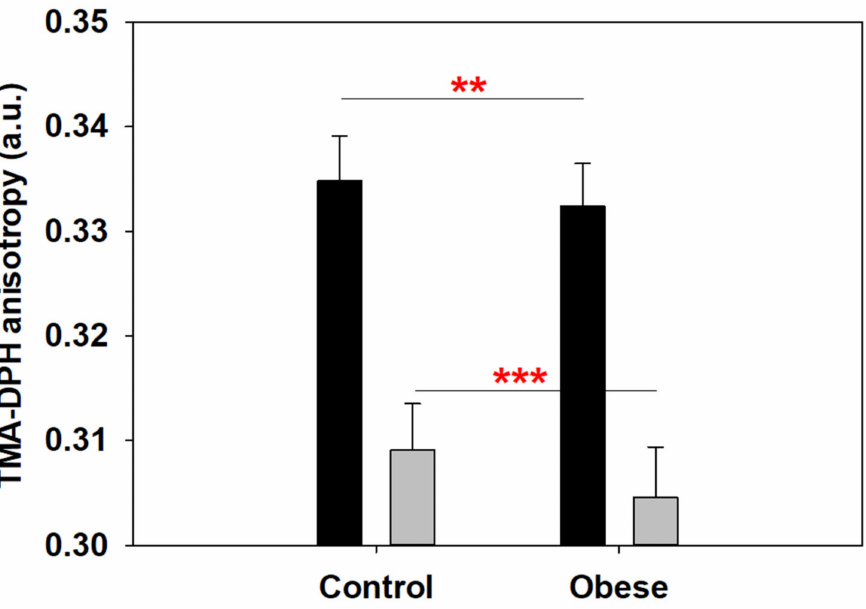
Figure 3. TMA-DPH anisotropy measurements of RBC membranes. The black bars represent mea- surements at 20 ◦ C, while gray ones represent those at 37 ◦ C. At both temperatures, a clear decrease for anisotropy values was detected for obese patient RBC, which indicates a higher membrane fluidity ( n = 49 for control, n = 52 for obese). Average values ± S.D. Significance according to Student’s t-test: (**) p < 0.01; (***) p <